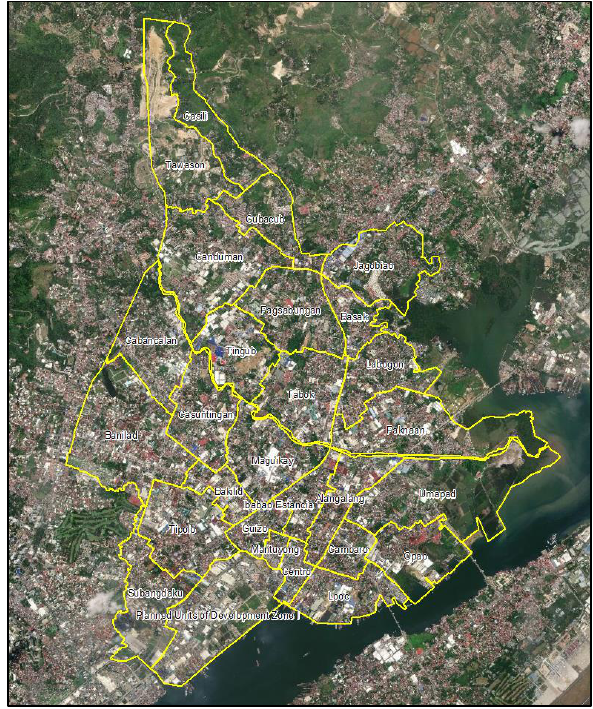
Figure 1. Map of Mandaue City showing barangay boundaries